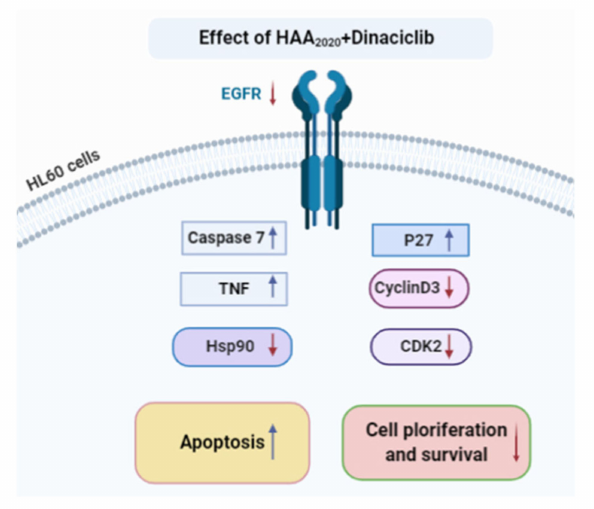
Figure 8. The e ff ect of the HAA 2020 and dinaciclib combination on apoptosis, cell proliferation and survival of HL60 cells. Created in